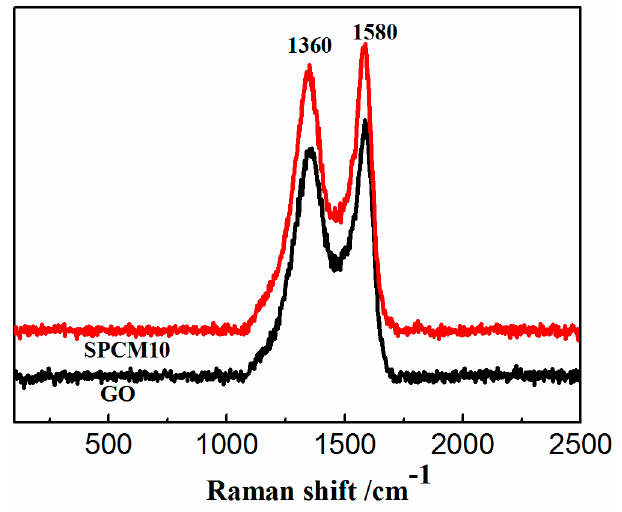
Figure 1. Fourier-transform infrared (FTIR) spectra of ( a ) graphene oxide (GO) and poly(tetradecyl acrylate- co -hexadecyl acrylate) (P(TDA- co -HDA)), and ( b ) the shape-stabilized phase change materials (SPCMs).